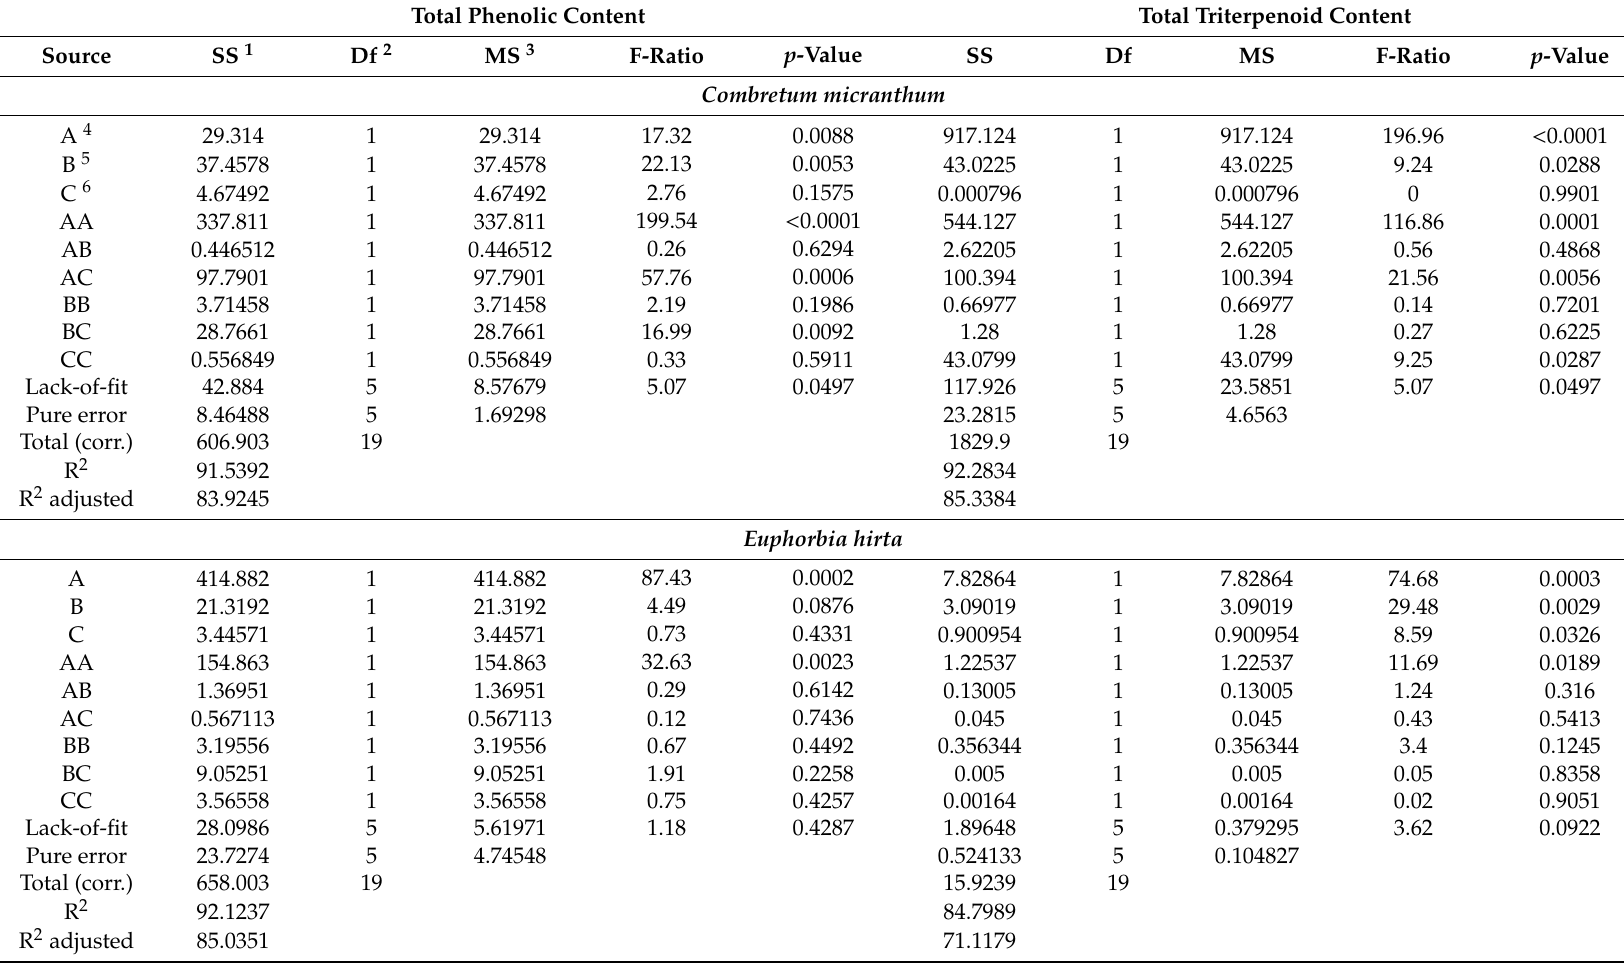
Table 2. Analysis of variance (ANOVA) for the second order polynomial models of Combretum micranthum leaves, Euphorbia hirta plant and Anacardium occidentale